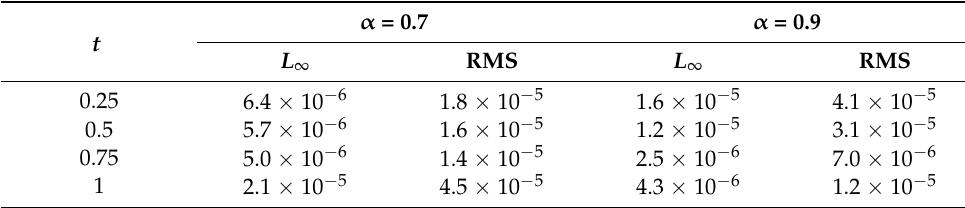
Table 3. Error norms of wavelet solution at different times t for Example 3.